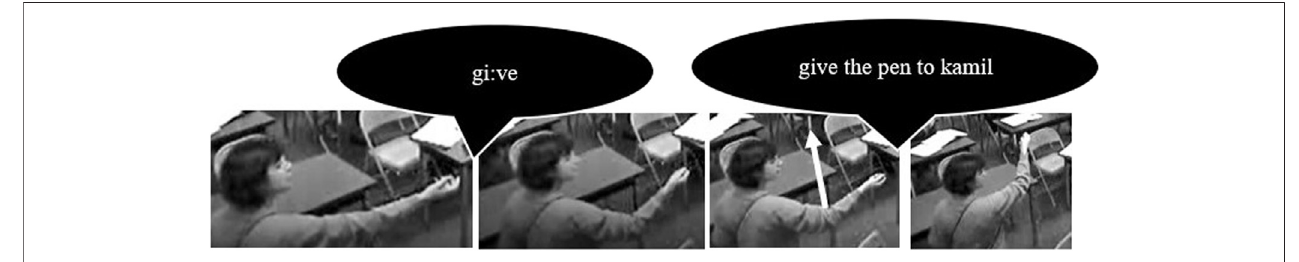
FIGURE 9 | Extract 5. line 1.